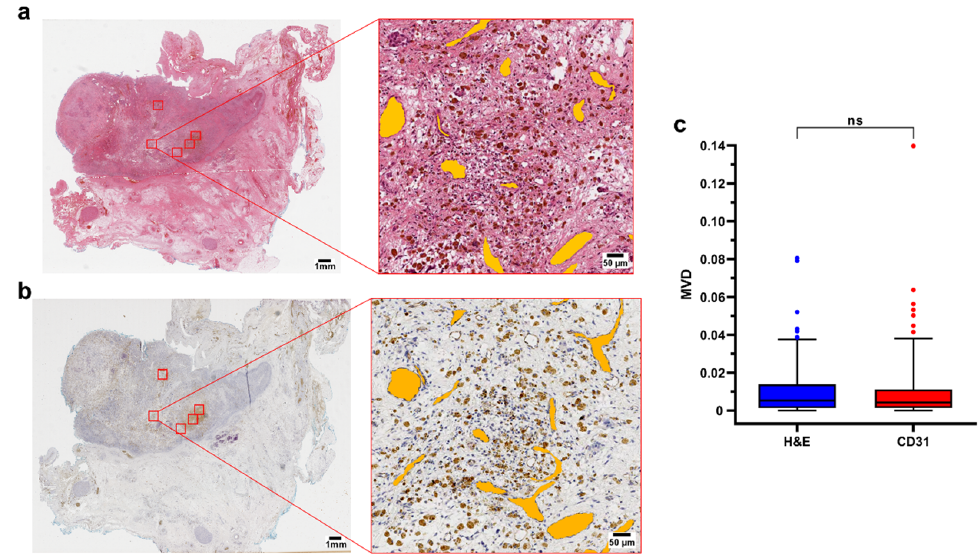
Figure 1. ( a , b ) Representative H&E and CD31 immunohistochemistry of a surgical sample (case 2, pdNB). ROIs are highlighted in red in the whole slide section (left). Filled annotations (orange) of the vessels of one of the regions are shown on the right side of the panel; ( c ) Boxplot showing data distribution for H&E ( n = 150) and CD31 ( n = 149) ROIs. Box represents the interquartile range. Bars represent the 5–95% range. Abbreviations: MVD = mean vascular density; H&E = hematoxylin and eosin; ns=not significant